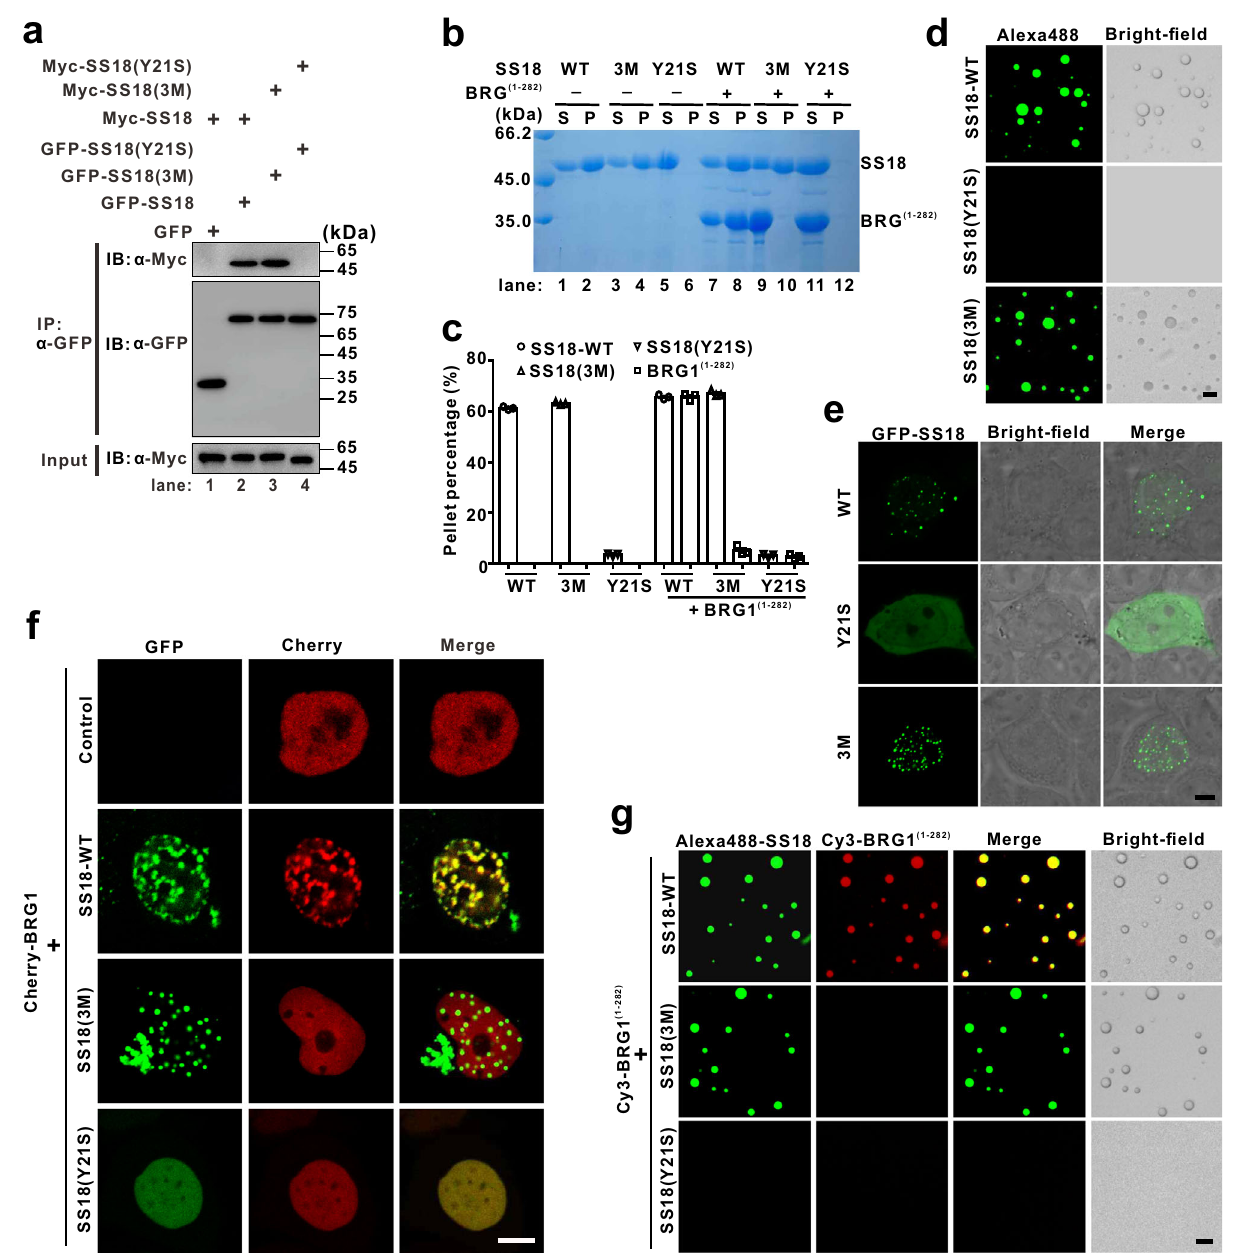
Fig. 4 Speci fi c recruitment of BRG1 into SS18 phase-separated condensates through tyrosine residue-mediated multimerization. a Co-IP experiments testing the self-association ability of SS18 or its mutants. Extracts were prepared from HEK293T cells transfected with combinations of plasmids, as indicated. The bottom panel shows 3% of the Myc-SS18 as input for each IP. Representative SDS-PAGE analysis ( b ) and quantitative data ( c ) for sedimentation assay of SS18 WT, mutants, or various SS18/BRG1 (1-282) mixtures, as indicated. The concentration of each protein is 60 µ M. The band intensities of proteins were quanti fi ed with Image J v1.8.0 software. The statistical data represent results from three independent batches of sedimentation experiments and are plotted as mean ± SEM. d Fluorescence and bright- fi eld images of SS18 WT or mutant droplets at the protein concentration of 60 µ M. Liquid droplets are enriched in Alexa Fluor 488-labeled SS18 WT or mutant. The scale bar indicates 10 μ m. e Representative fl uorescence images of GFP- SS18(WT), GFP-SS18(Y21S), and GFP-SS18(3M) in HEK293T cells. The scale bar indicates 5 μ m. f Co-localization of GFP-SS18-WT or mutants and Cherry- BRG1 in HEK293T cells. The scale bar indicates 5 μ m. g Representative fl uorescence and bright- fi eld images of the mixture of Alexa Fluor 488-labeled SS18 or mutants (60 µ M) and Cy3-labeled BRG1 (1-282) (60 µ M) in the buffer comprised 50 mM Tris-HCl pH 7.5 and 150 mM NaCl at room temperature. The scale bar indicates 10 μ